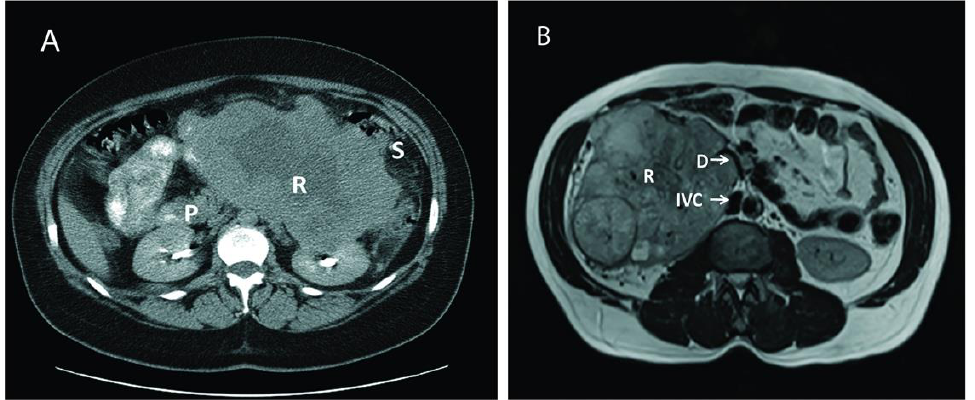
Figure 1. Computed tomography (CT) and magnetic resonance imaging (MRI) of two different patients with large renal mass. A: CT of a large left renal mass with lack of soft tissue planes between pancreas, spleen, and splenic flexure; B: MRI of a right large solid and cystic enhancing mass replacing the right renal parenchyma with mass effect and compression of proximal duodenum. P: Pancreas; R: Renal Tumor; S: Splenic flexure of colon; IVC: Inferior Vena Cava: D: Duodenum.